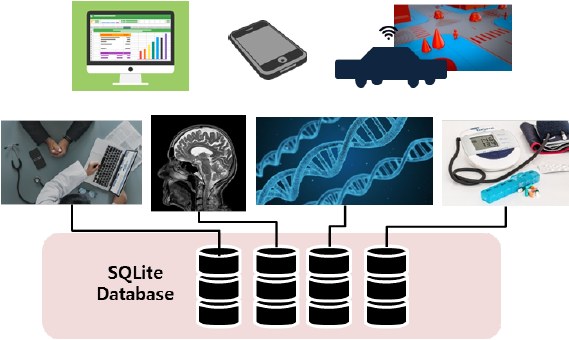
Figure 1. Applications for